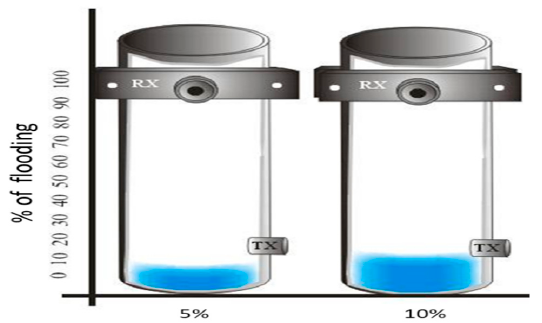
Figure 6. Experiment setup using a hollow steel pipe, 1.5 m × 270 mm × 2 mm, a PPM transmitter, and a DSP instrumentation receiver connected to a PC via USB port.